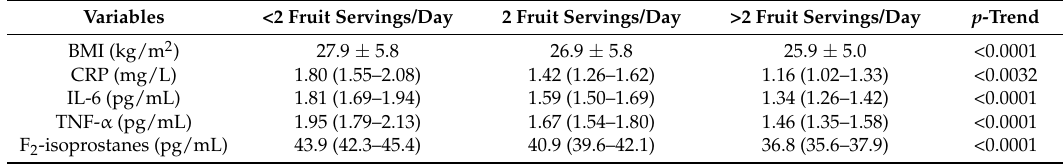
Table 3. Servings of fruit and BMI and inflammatory biomarkers in US adults